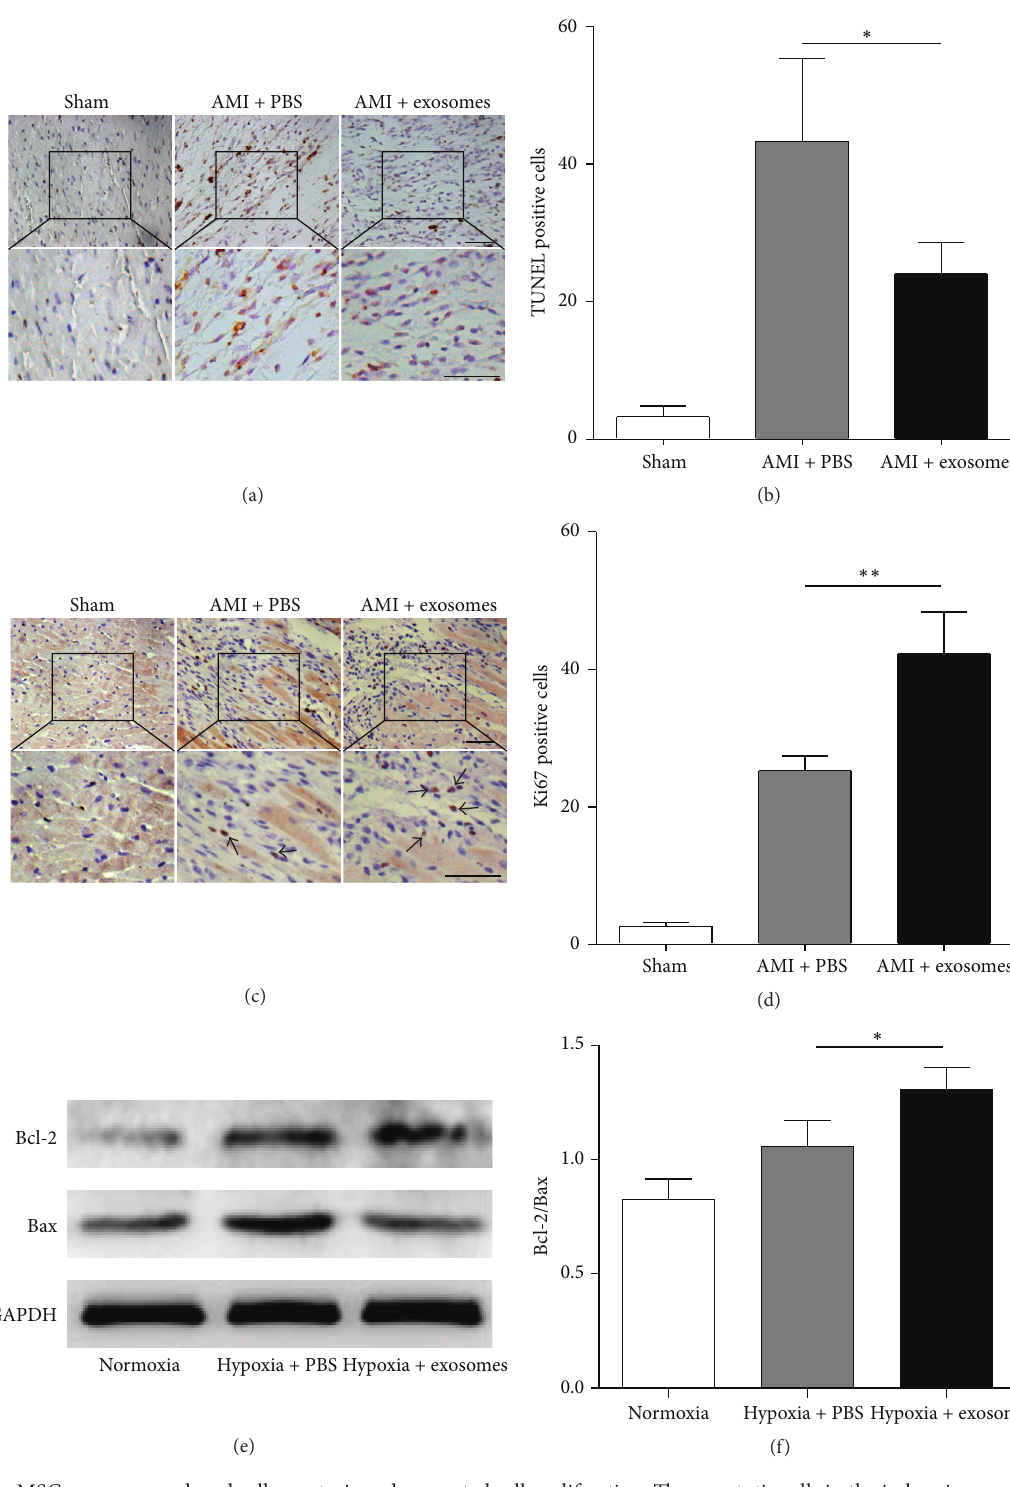
Figure 6: hucMSC-exosomes reduced cell apoptosis and promoted cell proliferation. The apoptotic cells in the ischemic zone of myocardial tissue sections (a). Scale bar = 50 𝜇 m. The numbers of TUNEL positive cells in 3 randomly selected fields at 200 times magnification for each rat (b). ∗ 𝑃 < 0.05 versus AMI + PBS. Immunohistochemical staining of Ki67 expression in myocardial tissue from the border zone of an infarcted left ventricle (c). The black arrows indicate Ki67 positive cells. Scale bar = 50 𝜇 m. The numbers of Ki67 positive cells in 3 randomly selected fields at 200 times magnification for each rat (d). ∗∗ 𝑃 < 0.01 versus AMI + PBS. The protein of Bax and Bcl-2 in the myocardial cells H9C2(2-1) cultured under hypoxic conditions was evaluated by western blot (e). Statistical analysis of the ratio of Bcl-2 to Bax (f). ∗ 𝑃 < 0.05 versus Hypoxia +